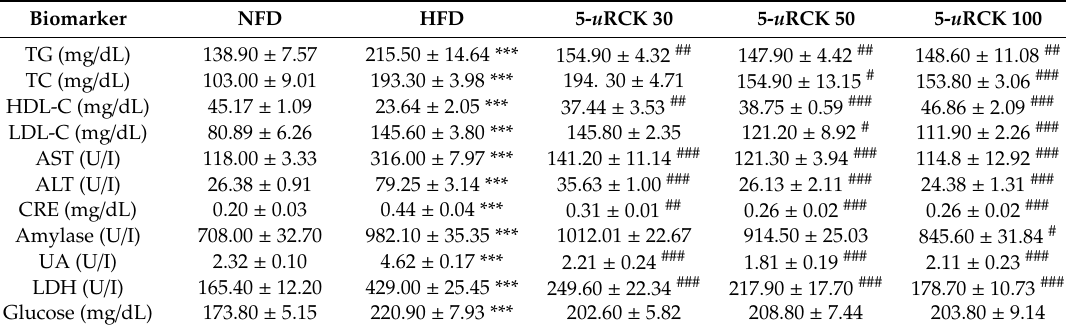
Table 3. E ff ect of 5- u RCK on blood biochemical parameters in HFD-fed mice.